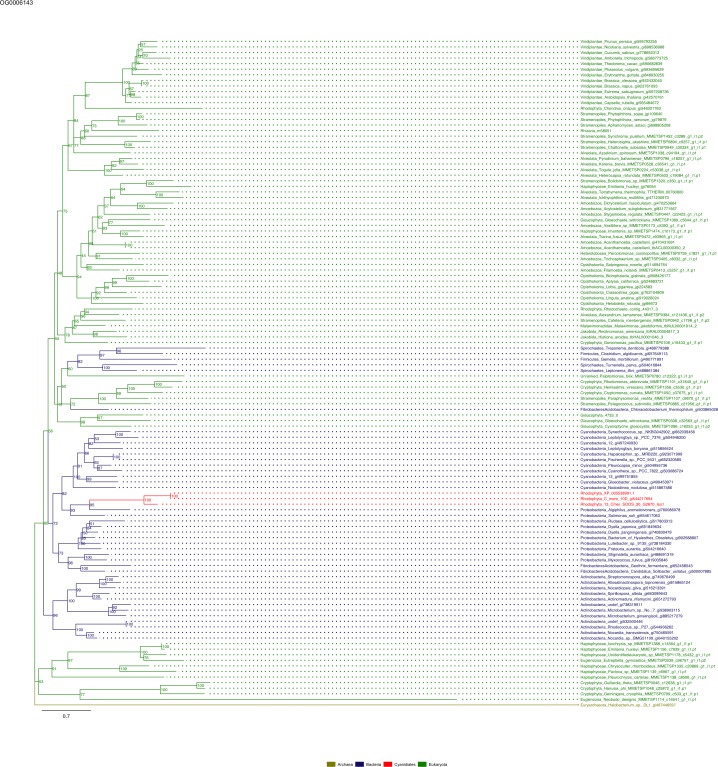
Sequence tree of orthogroup OG0006143.The tree is based on amino acid sequences. Archaea (yellow), Bacteria (blue), Cyanidiales (red), Eukaryotes including other red algae (green). Branches containing Cyanidiales sequences are highlited in red.